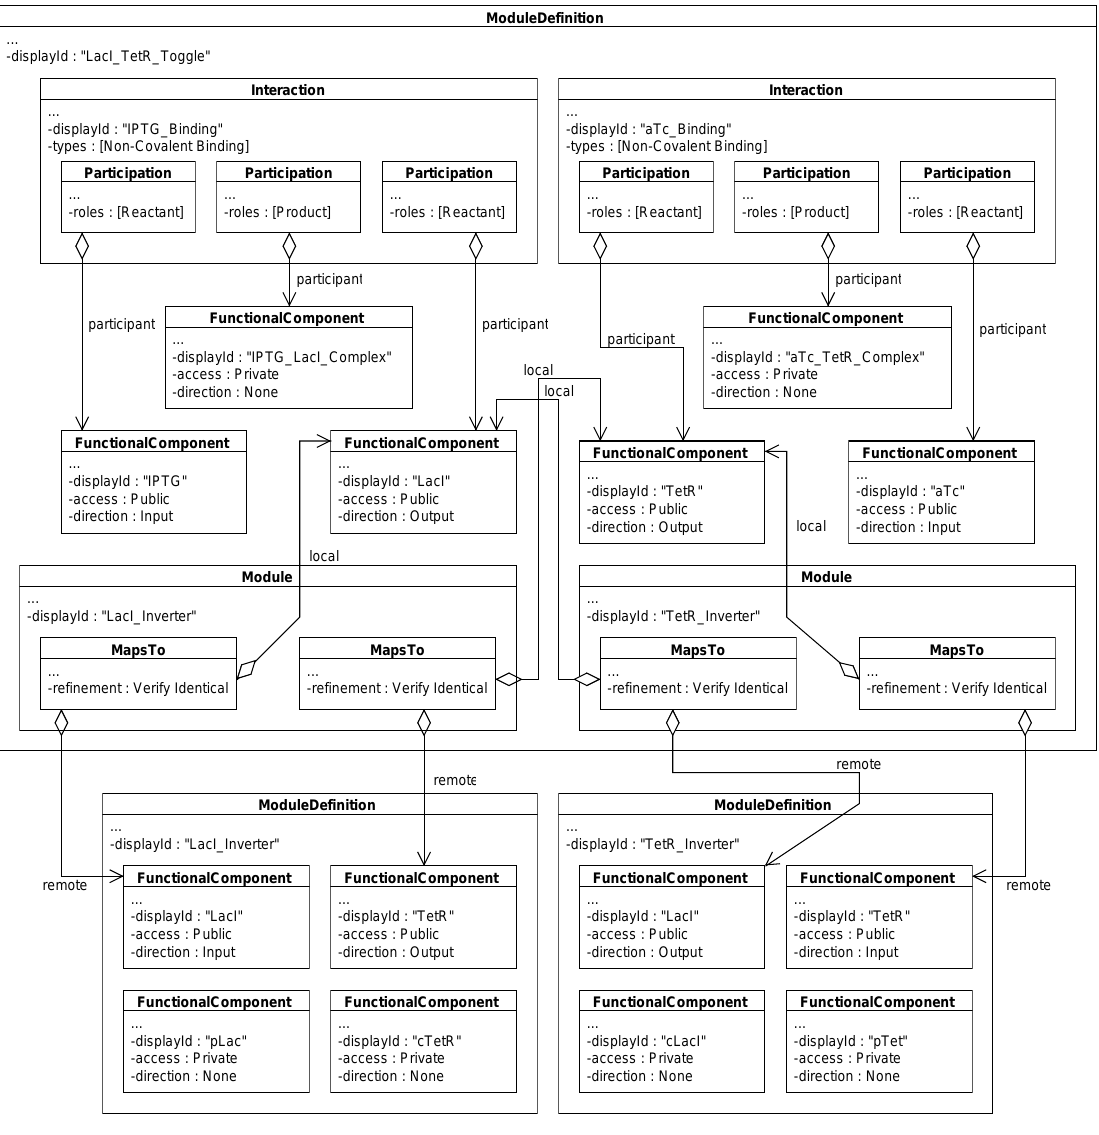
Figure 28: Composite ModuleDefinition of the LacI/TetR toggle switch. This ModuleDefinition contains the Module objects that instantiate LacI and TetR inverter ModuleDefinition objects. It also contains FunctionalComponent objects that instantiate the ComponentDefinition objects for the LacI/TetR transcription factors and IPTG/aTc small molecules. These FunctionalComponent objects each participate in a non-covalent binding Interaction . To com- plete the composition of the toggle switch, MapsTo objects are used to indicate that the output of the LacI inverter ModuleDefinition is identical to the input of the TetR inverter ModuleDefinition and vice versa.